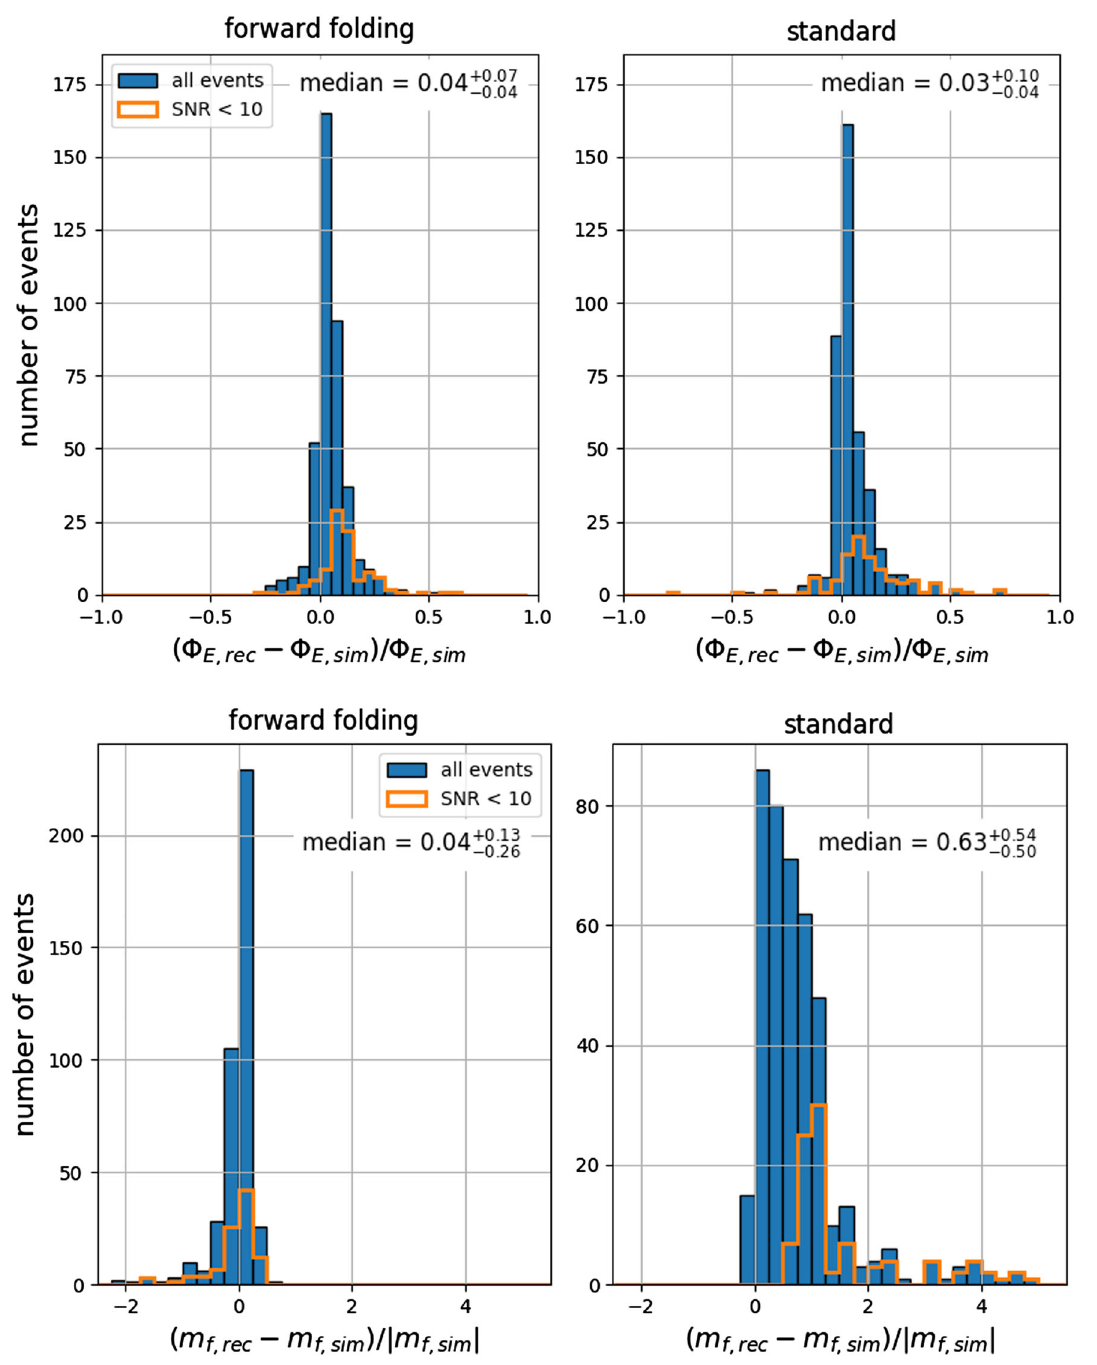
Fig. 9 Top row: resolution of the reconstructed energy fluence using 68% quantiles. Bottom row: Relative uncertainty on the reconstructed the forward folding (left) and standard methods (right). The orange line frequency slope m f using the forward folding (left) and standard (right) indicates events with signal-to-noise ratios smaller than 10. For the for- method. The orange line indicates events with signal-to-noise ratios ward folding method, the distribution’s median is 0 . 04 + 0 . 07 − smaller than 10. For the forward folding method the distribution has a and for the 0 . 04 median of 0 . 04 + 0 . 13 − and for the standard method a median of 0 . 63 + 0 . 54 − , with the uncertainties specifying the standard method it is 0 . 03 + 0 . 10 − 0 . 26 0 . 04 with the uncertainties specifying the 68% quantiles + 0 . 10 energy fluence that is calculated as integrated quantity around relative uncertainty of 0 . 03 − 0 . 04 and with the forward folding + 0 . 07 the signal pulse, making the energy fluence a robust estimator a median of 0 . 04 − 0 . 04 . The reason for a similar performance in the presence of noise is that the average noise contribution is subtracted from the